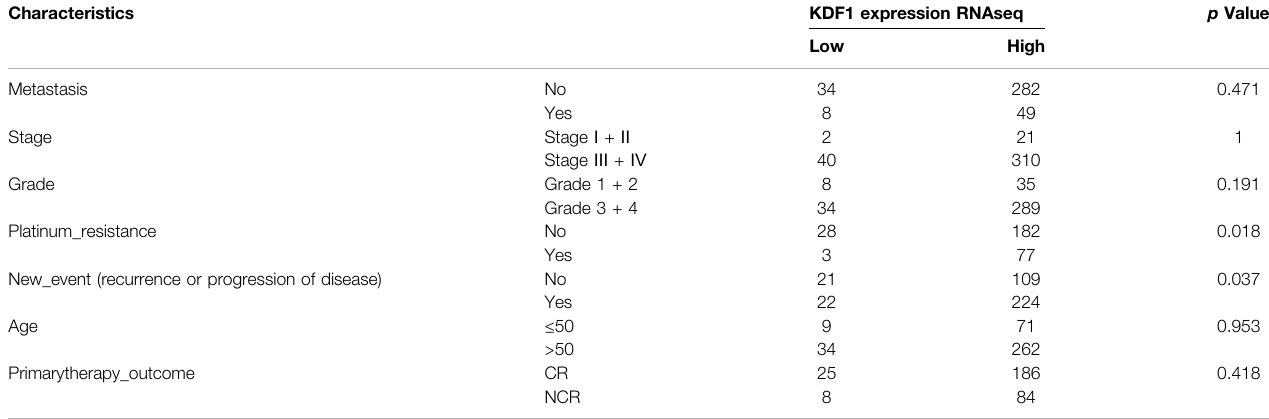
TABLE 1 | Difference of clinical characteristics between high- and low-expression groups of KDF1. Characteristics